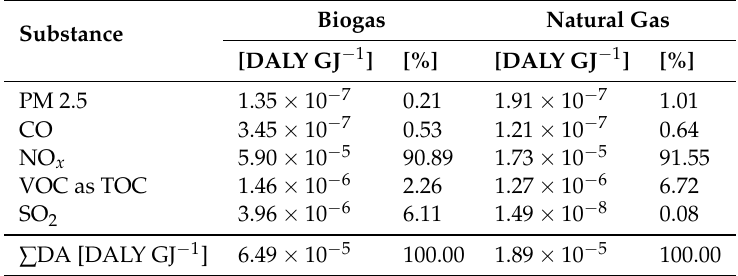
Table 18. Damage assessment of regulated emissions of biogas and Natural gas. Substance